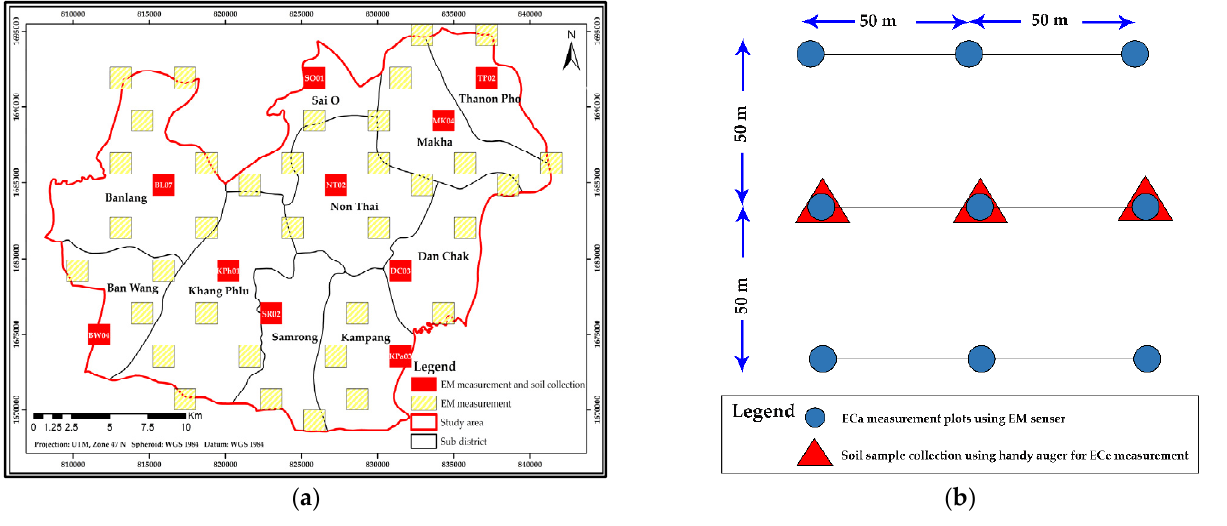
Figure 4. ( a ) Distribution of ECa and ECe measuring sites; ( b ) Sampling design for ECa measurement and soil profile collection for ECe measurement in ten representative sub-districts.